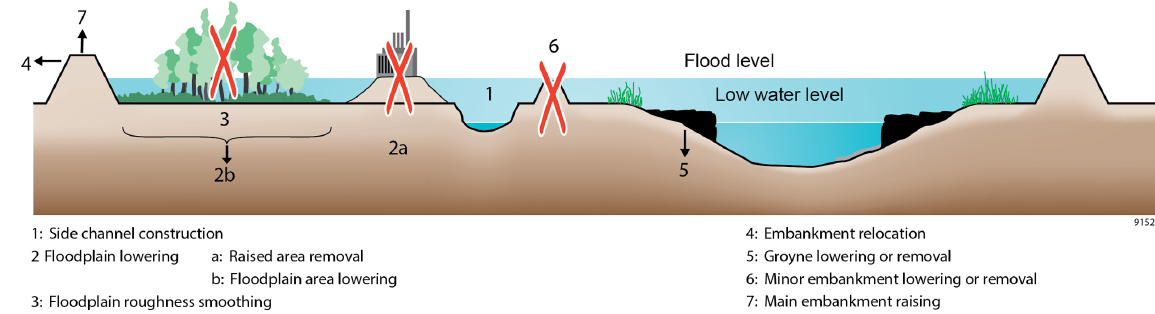
Figure 3. Typical landscaping measures implemented in this paper (figure after Middelkoop and Van Haselen, 1999).